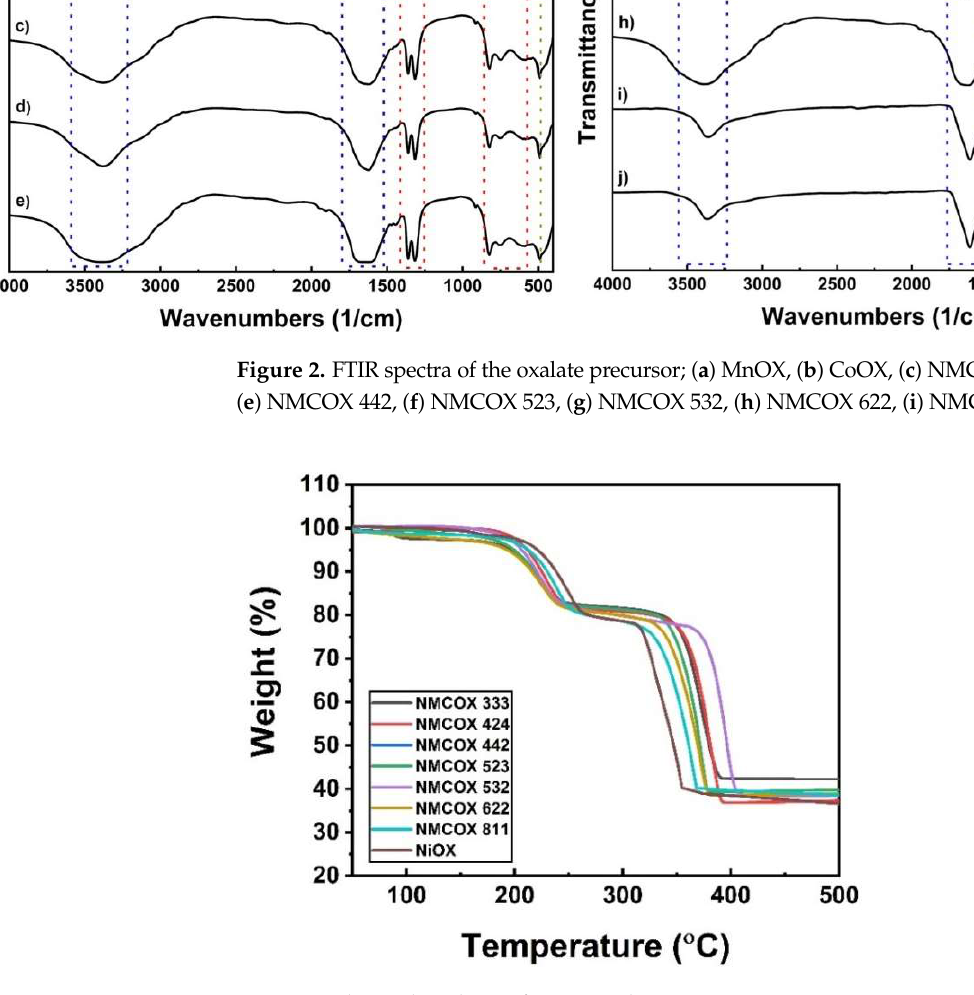
Figure 3. Thermal analysis of NiOX and NMCOX. Table 3. The temperature in the dehydration and decomposition stages of the